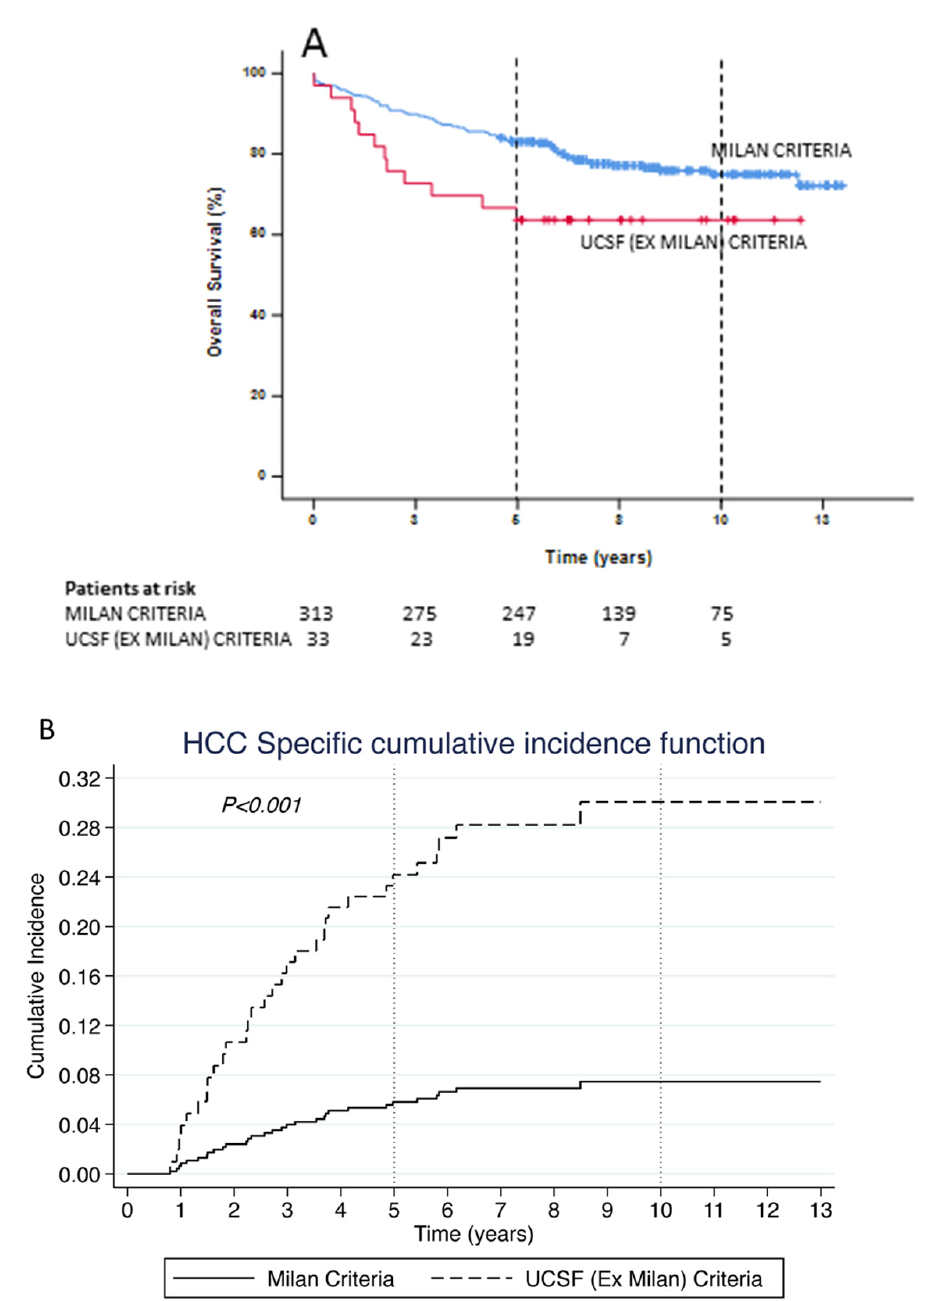
Figure 3. Kaplan–Meier Curves for ( A ) Overall survival for HCC following LT in the UCSF era comparing those transplanted within the Milan criteria (blue line) vs. those transplanted within UCSF but outside the Milan criteria (red line) and ( B ) HCC-related death following LT in the UCSF era comparing those transplanted within the Milan criteria (solid line) versus those transplanted within UCSF but outside the Milan criteria (dashed line).